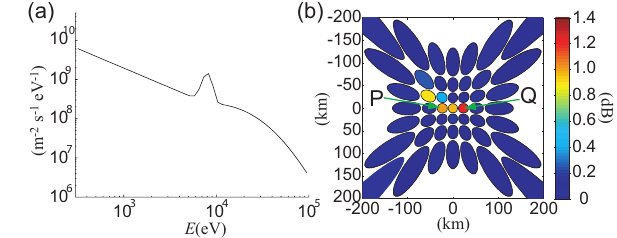
Fig. 8. (a) Energy distribution of the incident electrons at the center of the arc. The distribution is similar to Fig. 3b, but the high-energy tail has been replaced with a kappa distribution. (b) CNA detected with the IRIS at Kilpisj¨arvi. Top and right correspond to the north- ward and eastward direction, respectively. Note that the center of this panel corresponds to the position of Kilpisj¨arvi. Each colored area shows − 3dB contour of the main beam. Gaussian noise with a mean of 0dB and a standard deviation of 0.03dB has been added to the CNA data. P and Q are the beams where the precipitating electrons at points C and E in Fig. 3a contribute to the generation of